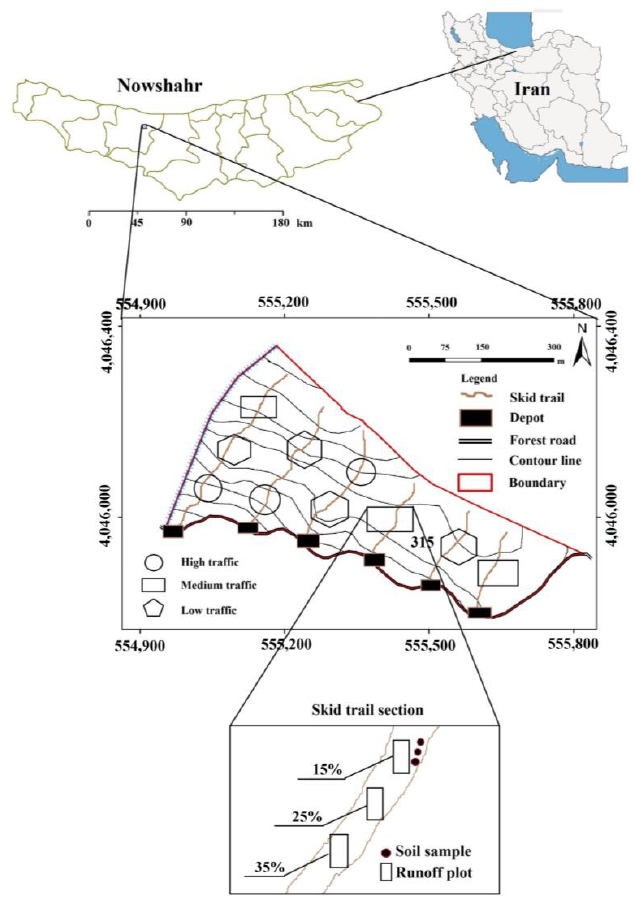
Figure 1. Layout of the study area and experimental design in the Hyrcanian forest.